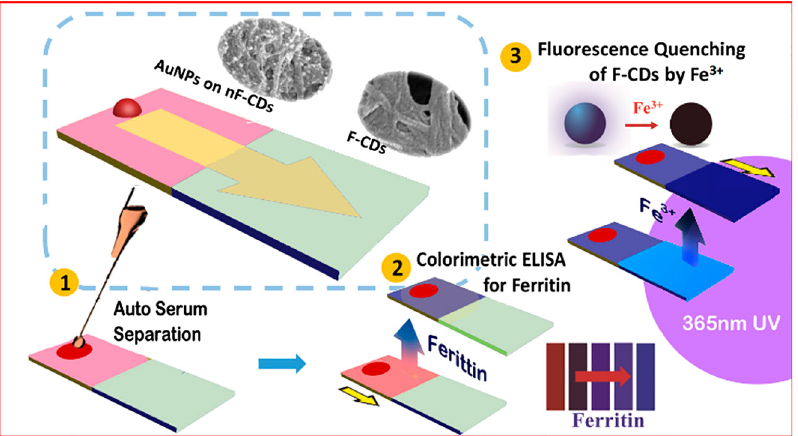
Figure 8: Schematic illustration of microfluidic paper analytical devices ( μ PADs) for the measurement of serum iron and serum ferritin in whole